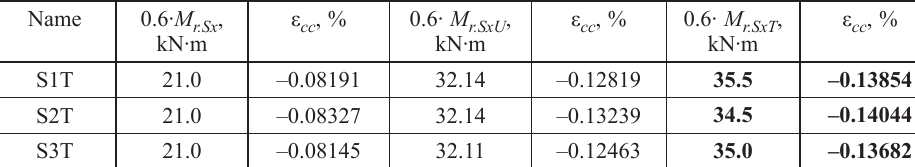
Table 8. Strains of the mostly compressed HPFRCC layer when M = 0.6· M r